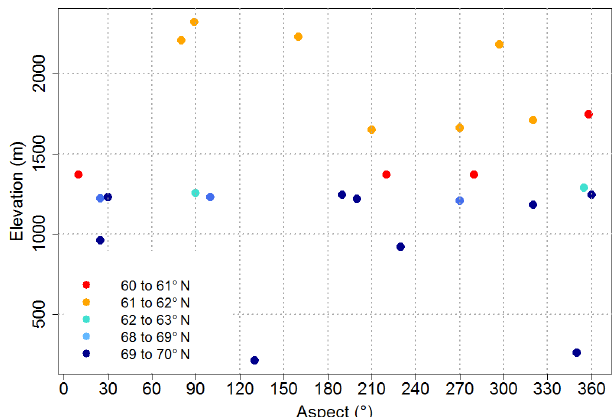
Figure 2. Distribution of the 25 loggers according to elevation, as- pect and